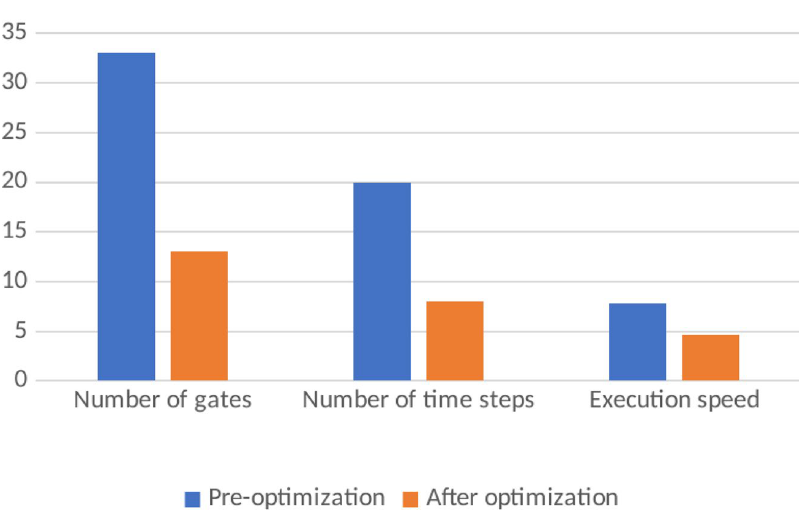
Figure 14. ( a ) Demonstration of original 30 , and ( b ) improved quantum circuits test for the KNN algorithm. The non-optimal circuit (a) is executed in 20 time steps, but the improved circuit, which has a reduction of 60.60% in the number of gates, its time step is reduced to 8.